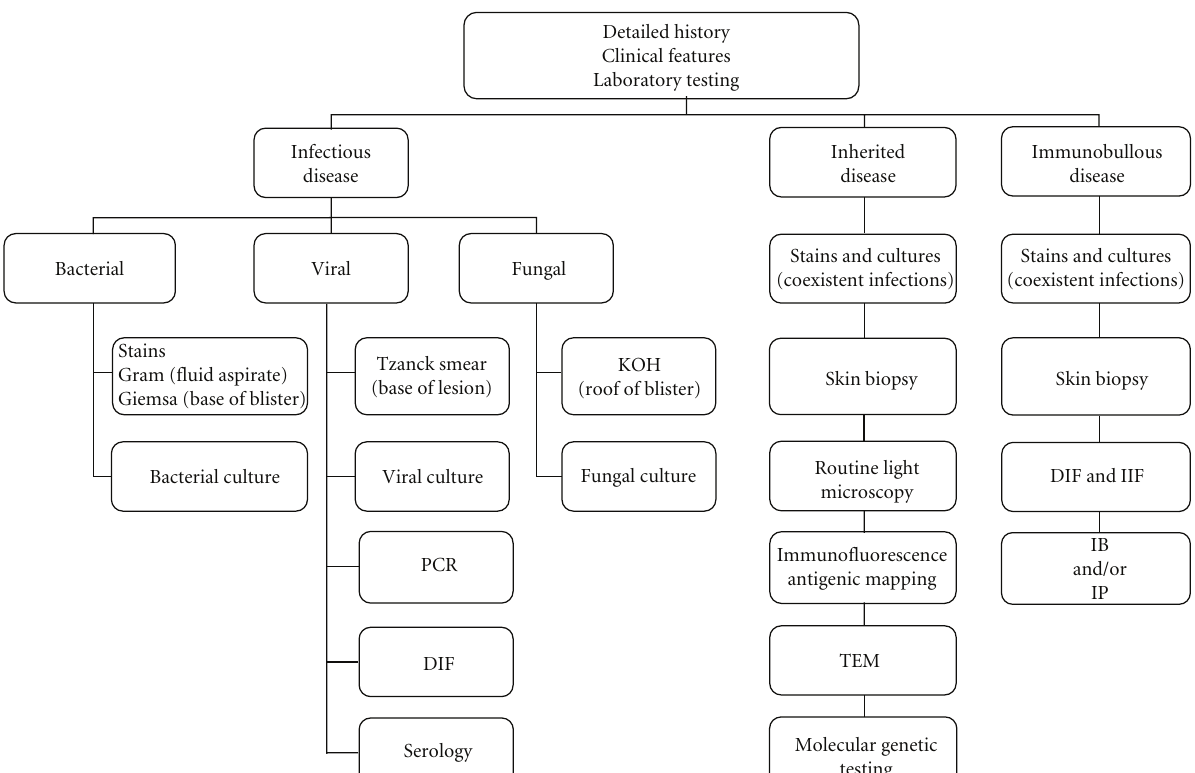
Figure 1: Diagnostic algorithm of blisters and erosions in newborns. DIF: direct immunofluorescence; IB: immunoblot; IIF: indirect immunofluorescence; IP: immunoprecipitation; KOH: potassium hydroxide fungal test; PCR: polymerase chain reaction: TEM: transmission electron microscopy.